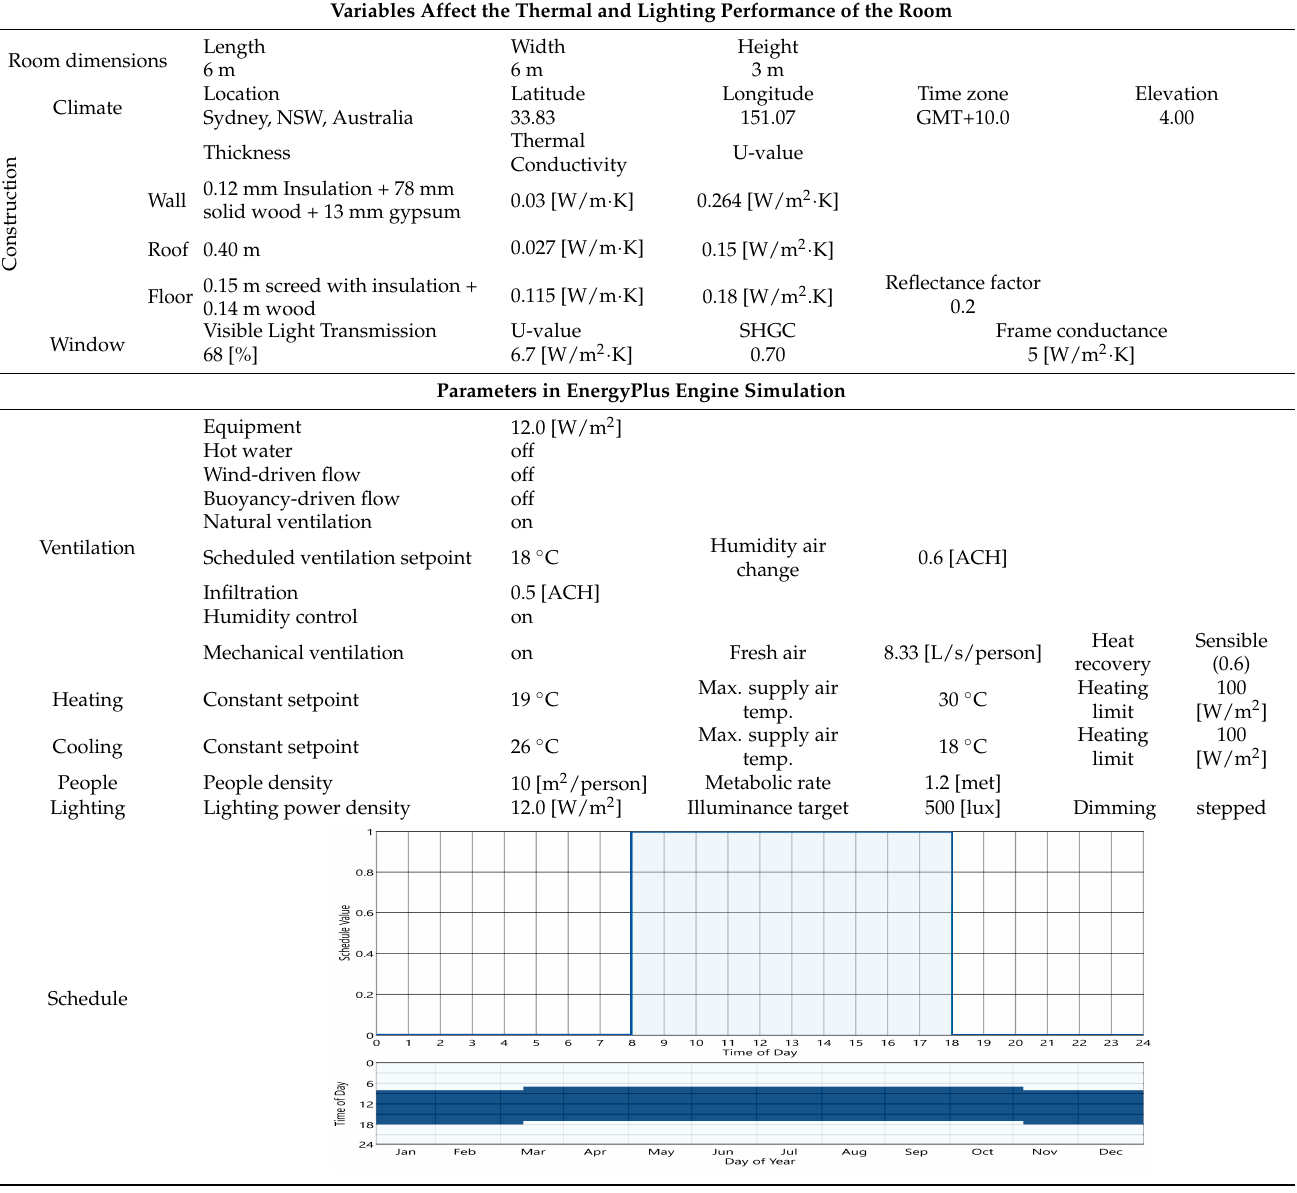
Table 1. The parameters applied in the simulations.